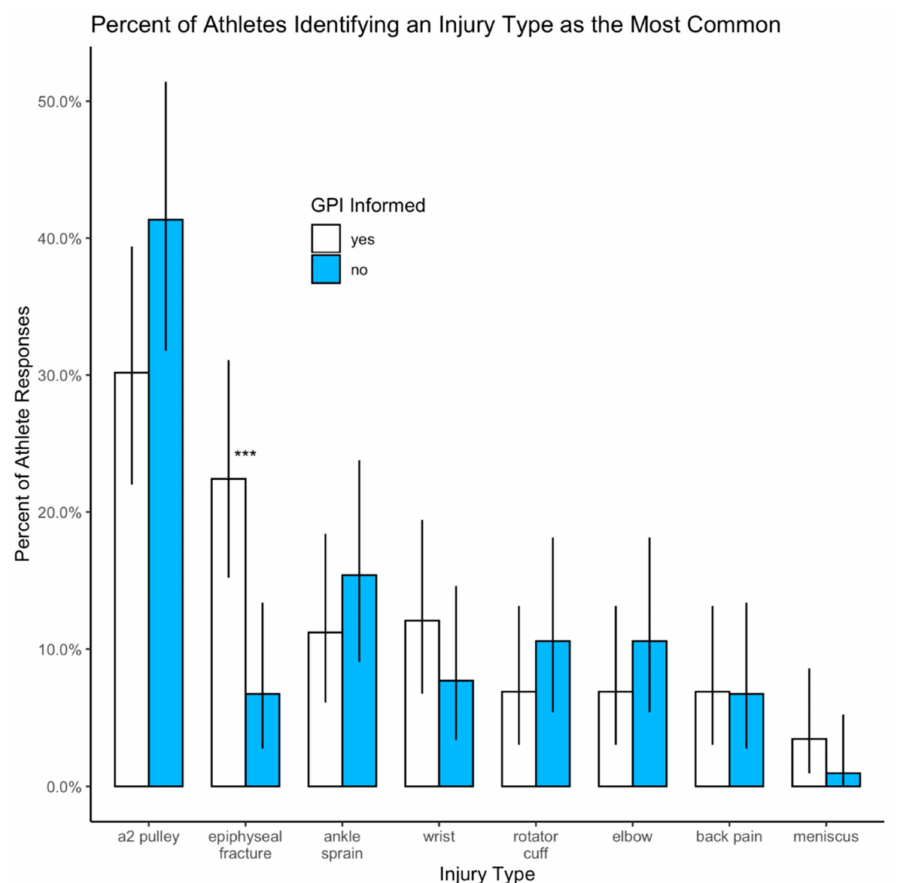
Figure 1. Identification of the most common injury type by GPI informed and GPI uninformed athletes. Significant di ff erences between the percentage of GPI informed and GPI uninformed for an epiphyseal fracture are indicated with three asterisks ( p <